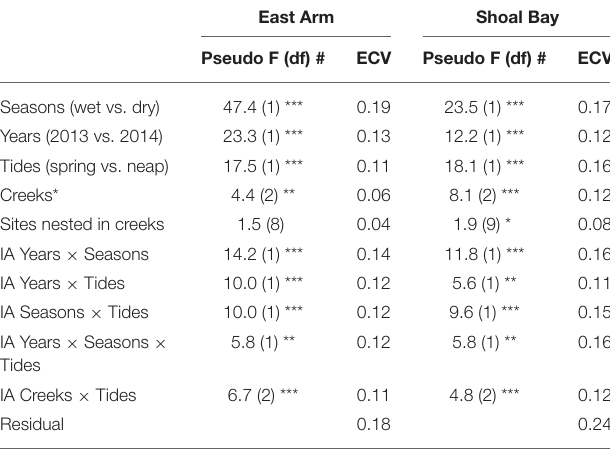
TABLE 1 | PERMANOVA analysis of water microbiota.